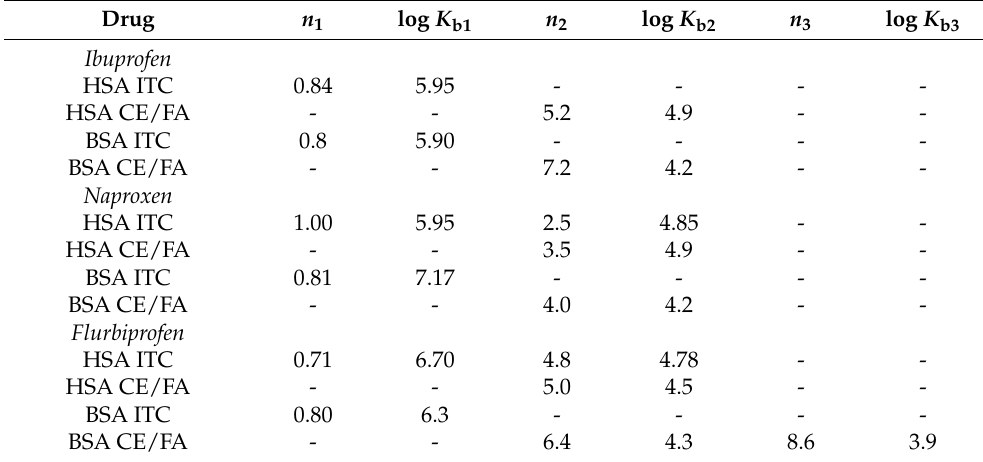
Table 4. Stoichiometry and binding constants obtained for the NSAIDs interactions with HSA and Bos taurus (BSA) using isothermal titration calorimetry (ITC) and capillary electrophoresis/frontal